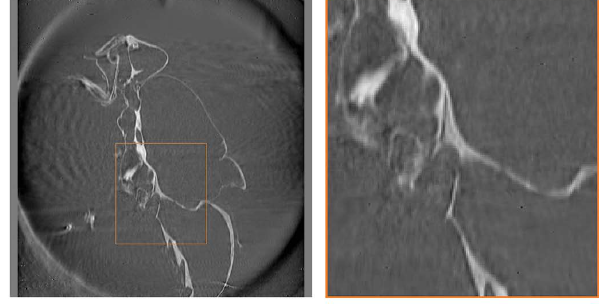
Figure 7 Comparison of resulting stack of tomograms after different denoising procedures on Fly , each obtained with filtered back-projection, where individual tomograms are horizontal lines. Displayed are slices of tomograms, reconstructed from, top-to-bottom: noisy projections Z (4), estimates ^ YY of the streak-free projections Y (5) denoised with Ma¨kinen et al. (2021), ^ YY from the proposed streak denoising, and the result of the proposed full denoising d ln ð A Þ ln ð A Þ . Note the horizontal ‘streaks’ in the estimate produced by Ma¨kinen et al. (2021), which arise from differences in estimates for consecutive slices; the proposed method is not prone to such artifacts, as it considers the full stack of projections in the denoising.